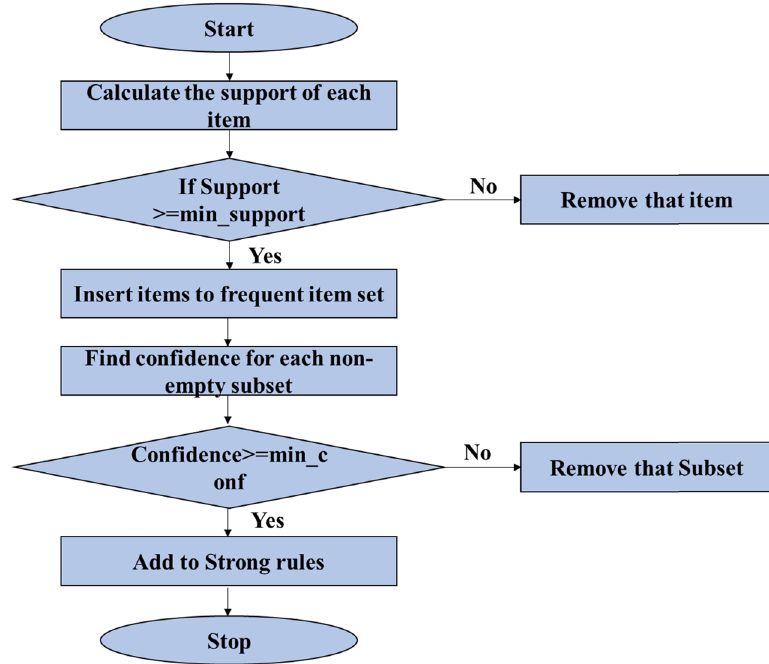
Figure 3: Flowchart of Apriori algorithm.